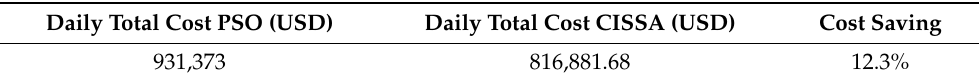
Table 22. Reduction in daily total cost — case study 2.